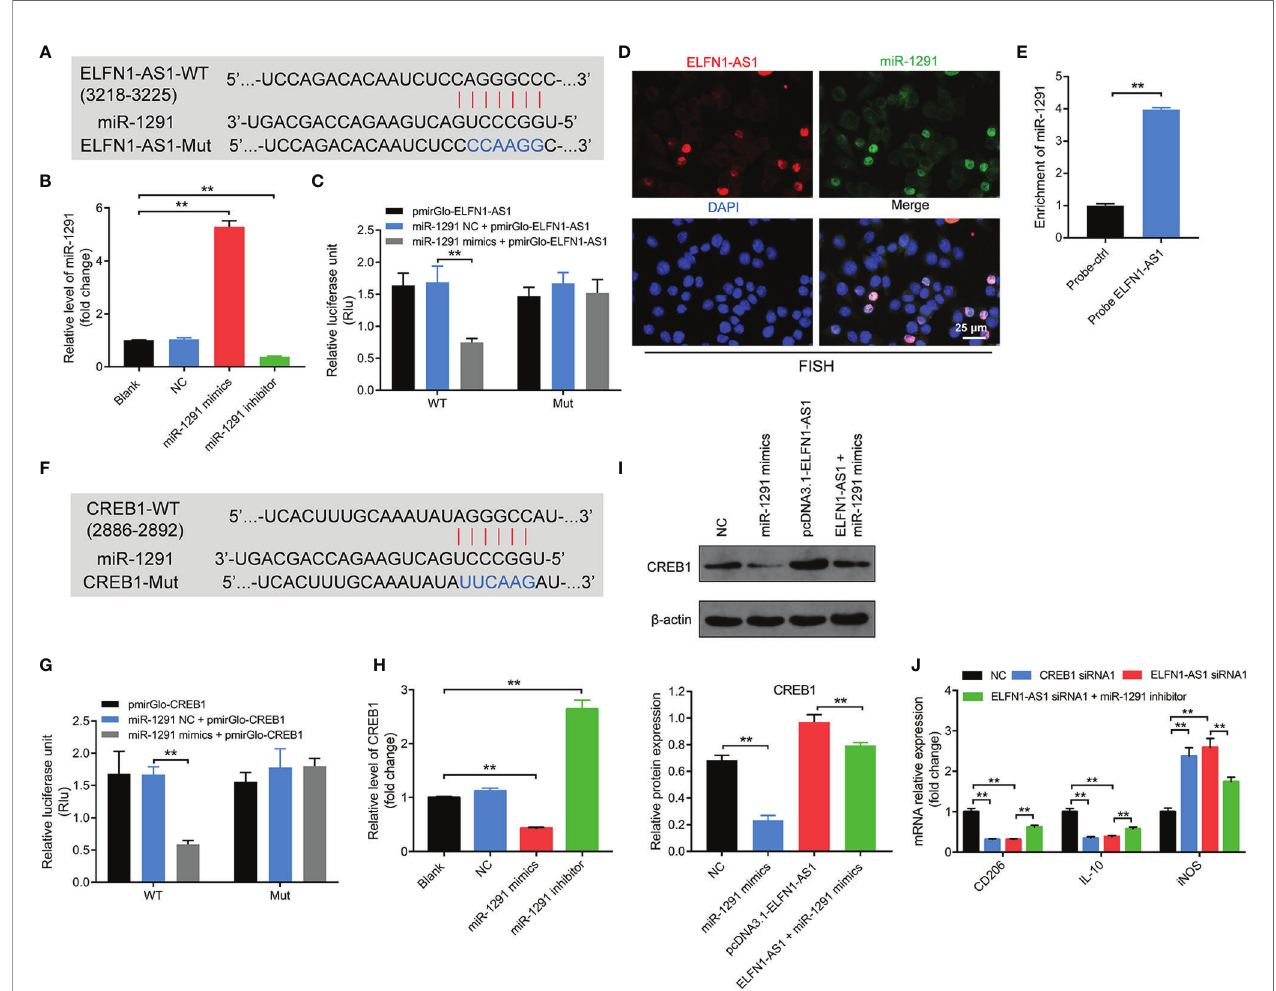
FIGURE 7 | Exosomal ELFN1-AS1 promoted macrophage M2 polarization via regulating miR-1291/CREB1 axis. (A) Schematic diagram of binding sites between ELFN1-AS1 and miR-1291. (B) RT-qPCR analysis of miR-1291 level in macrophages after transfecting with miR-1291 mimics and miR-1291 inhibitor (n = 3). (C) Luciferase activity in macrophages treated with the ELFN1-AS1-wt/mut plasmids together with miR-1291 mimics was analyzed (n = 3). (D) FISH detection of ELFN1-AS1 and miR-1291 in macrophages. (E) RNA pull-down assays were used to determine the interaction between ELFN1-AS1 and miR-1291 (n = 3). (F) Schematic diagram of binding sites between CREB1 and miR-1291. (G) Luciferase activity in macrophages treated with the CREB1-wt/mut plasmids together with miR-1291 mimics was analyzed (n = 3). (H) RT-qPCR analysis of CREB1 level in transfected macrophages (n = 3). (I) Western blot analysis of CREB1 expression in transfected macrophages (n = 3). (J) RT-qPCR analysis of CD206, IL-10, iNOS level in transfected macrophages (n = 3). The signi fi cance between two or more groups was analyzed by Student ’ s t test or one-way ANOVA respectively. **P <